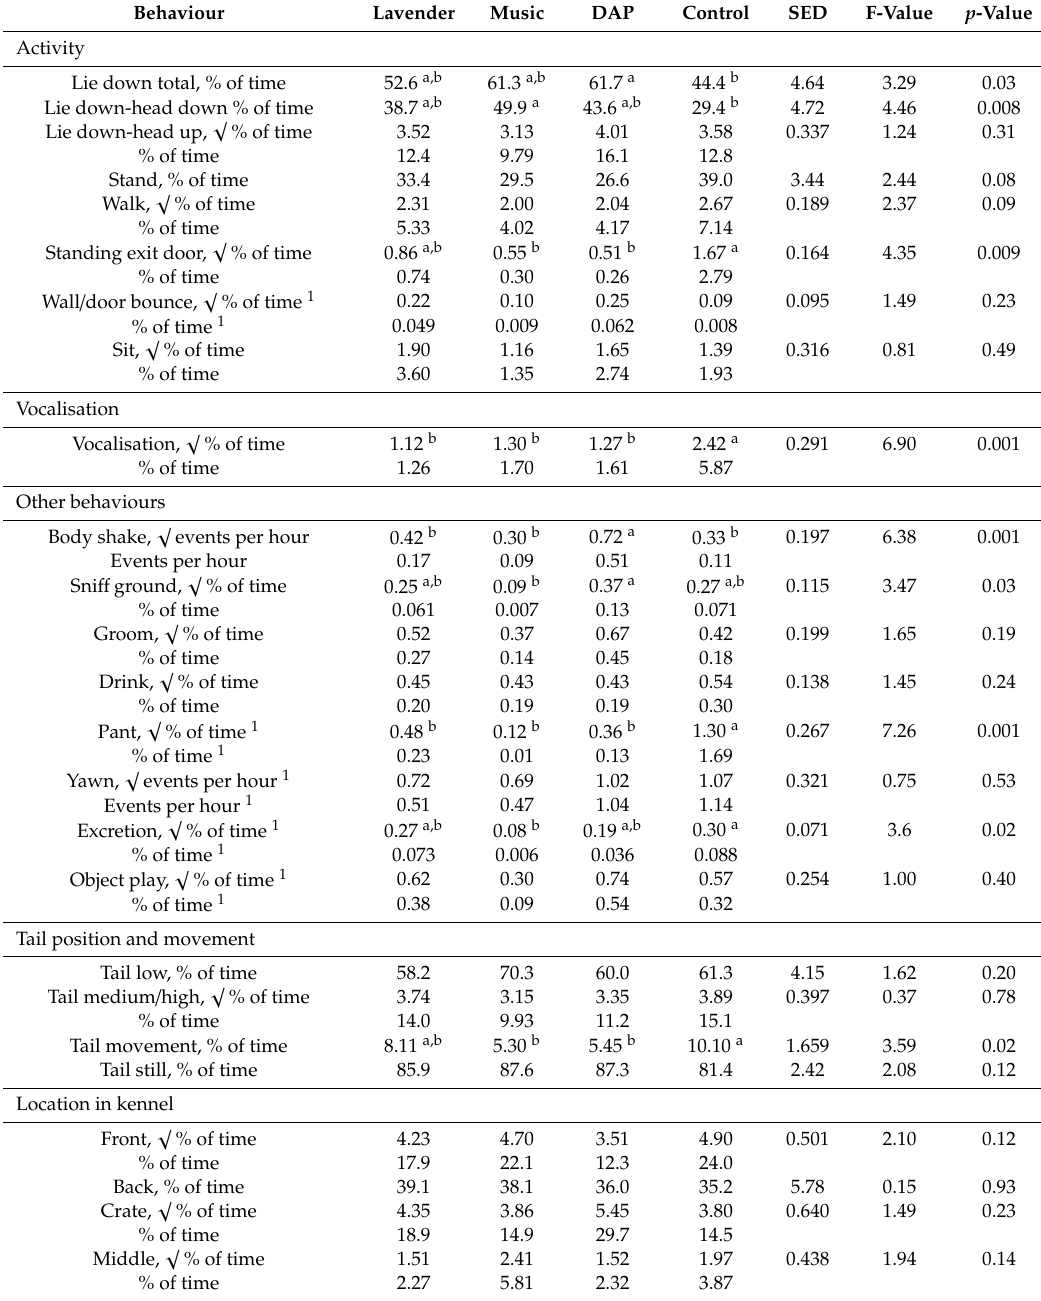
Table 2. The behaviour of dogs ( n = 60) exposed to Lavender, Music, DAP or a Control treatment, during the Treatment period. Behaviour